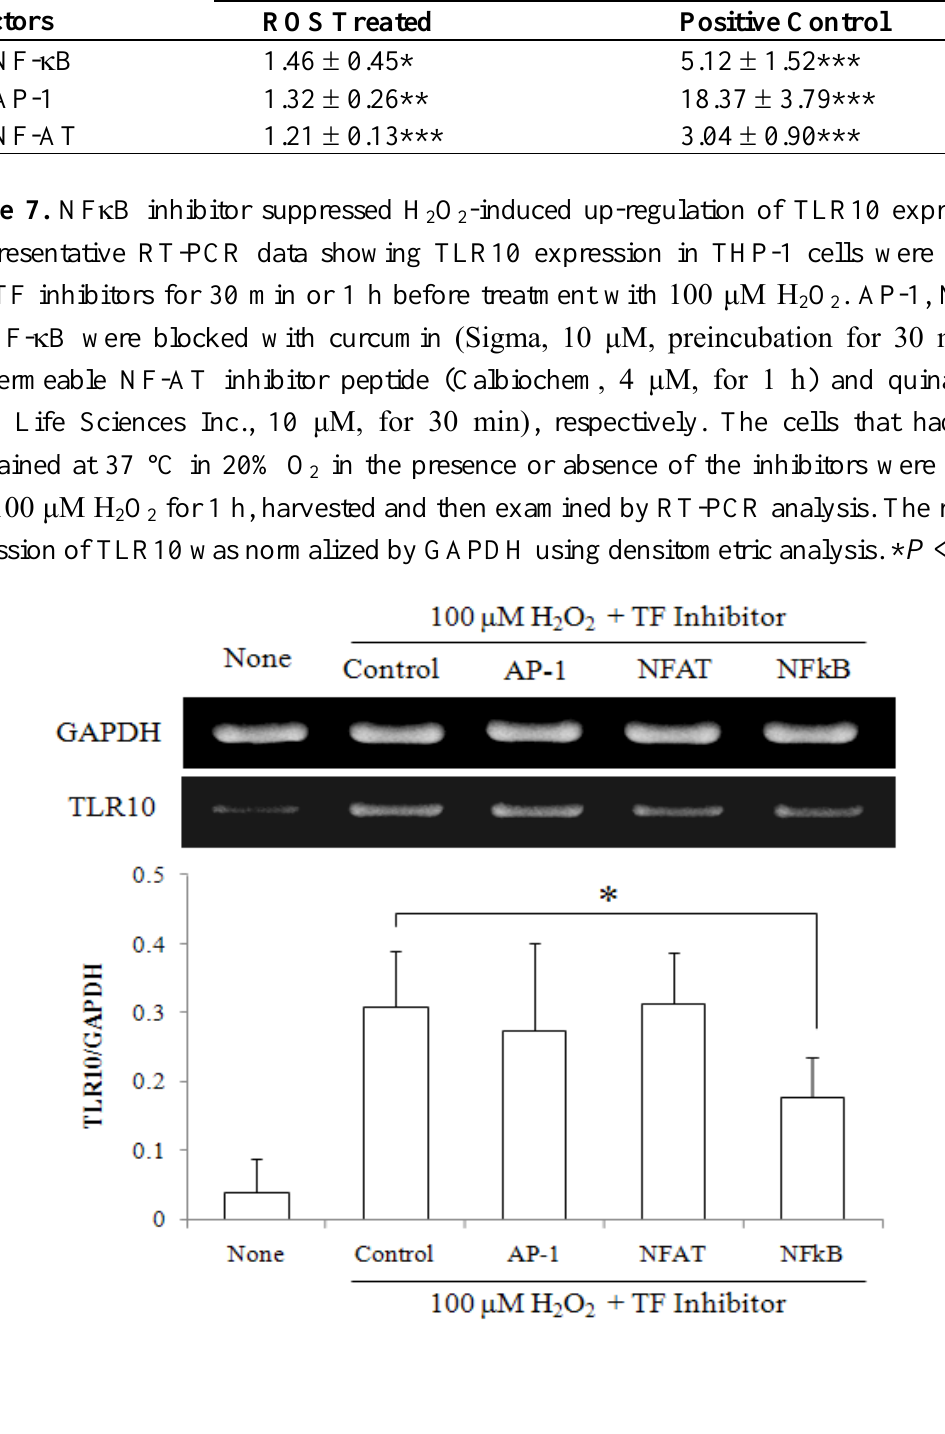
O versus 2 2 O for 2 2